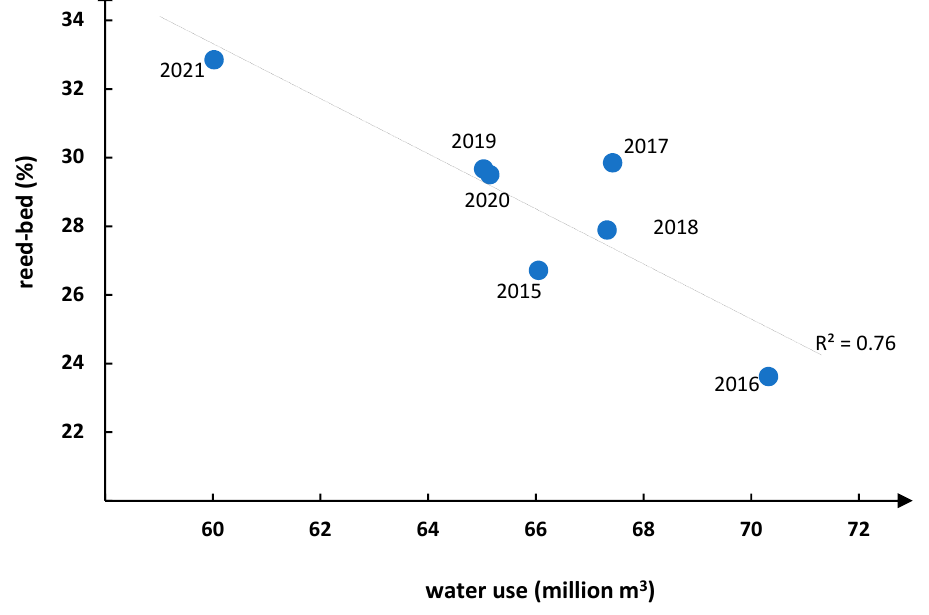
Figure 8. A comparative plot of annual values for water uses in pond aquaculture in the STD region according to official statistical reports versus the mapped reed area as a percentage of the total pond area.